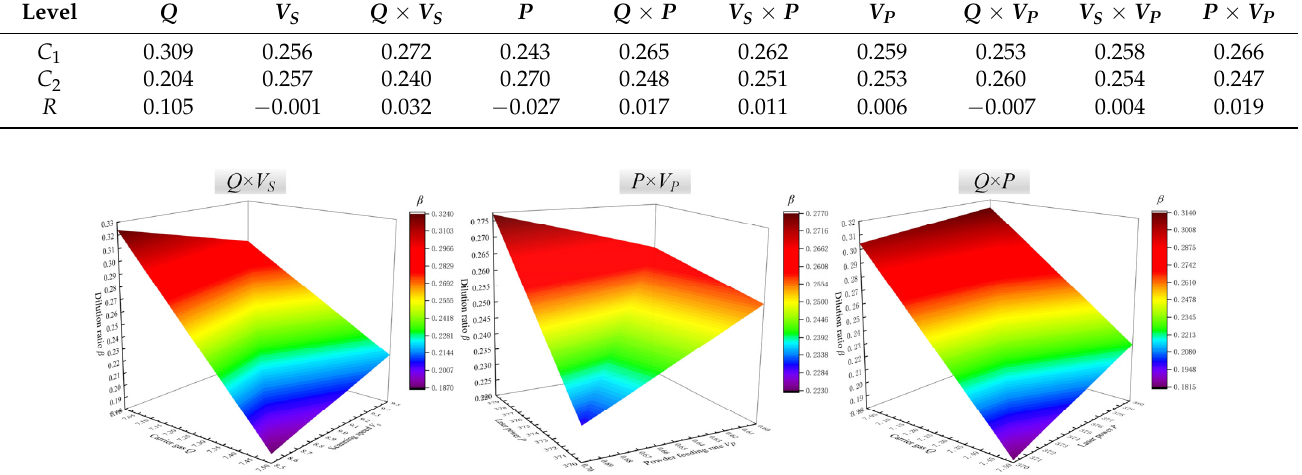
Figure 7. The interaction of the four parameters.